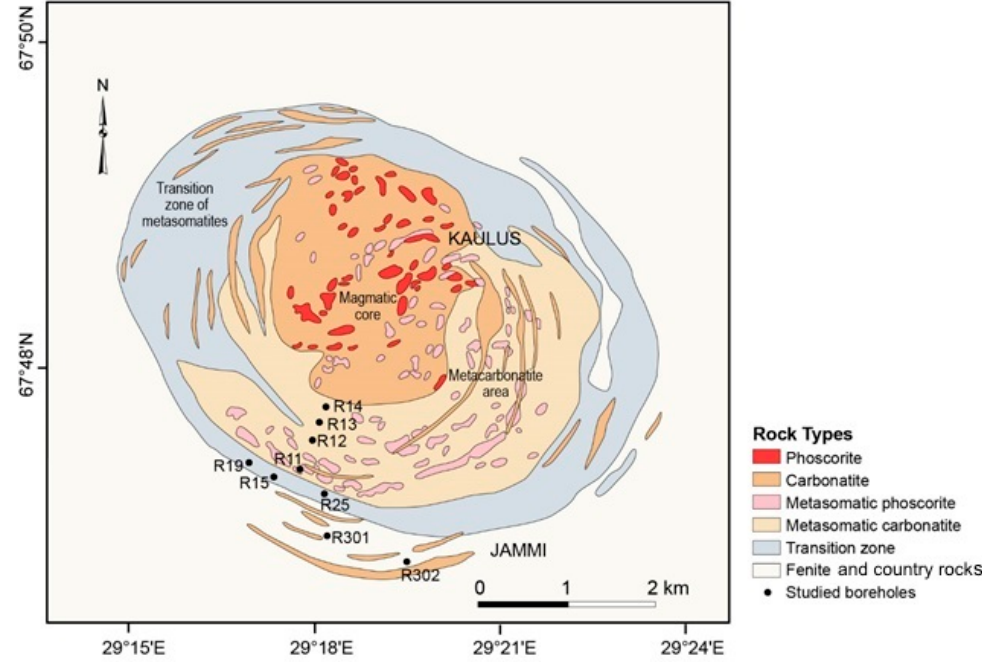
Figure 2. Geological map of the Sokli massif in the northern Finland. Modified after Vartiainen [20].